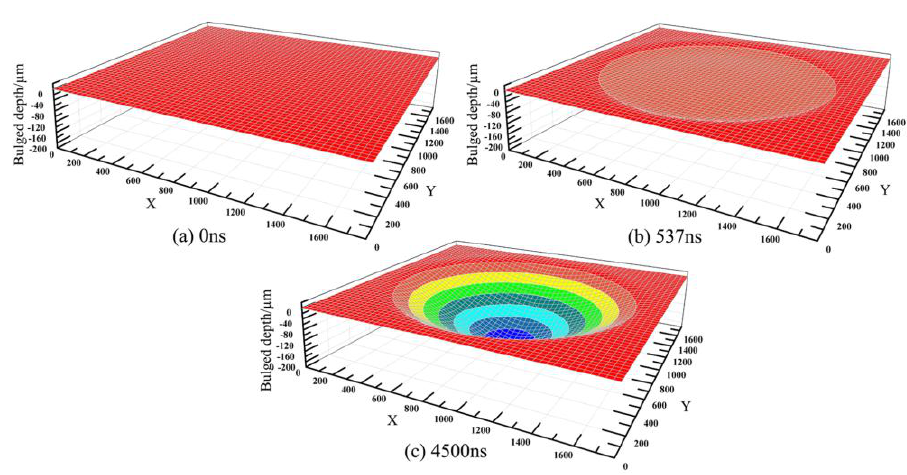
Figure 10. The deformation process of a workpiece in the simulation, ( a ) starting phase ( b ) bending phase ( c ) stretching phase.